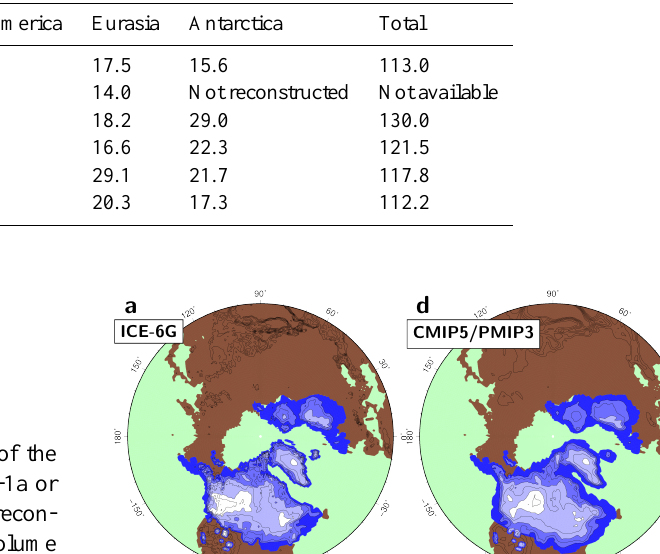
Table 2. Implied changes (Last Glacial Maximum–present) in ice volume for the Laurentide, Eurasian and Antarctic ice sheets, expressed in terms of impact on eustatic sea level (in m). The impact of eustatic sea level is inferred by assuming no change in ocean area compared to today (assumed ocean area: 360768576km 2 ), and using densities for ice and water of 910 and 1028kgm − 3 respectively. Results are shown for the three individual reconstructions (ICE-6G v.2, GLAC-1a, ANU) and for the composite CMIP5/PMIP3 ice sheets, and compared to the implied changes for the ice sheets used in the Last Glacial Maximum simulations run in the first and second phases of the Palaeoclimate Modelling Intercomparison Project (PMIP1, PMIP2). North America Eurasia